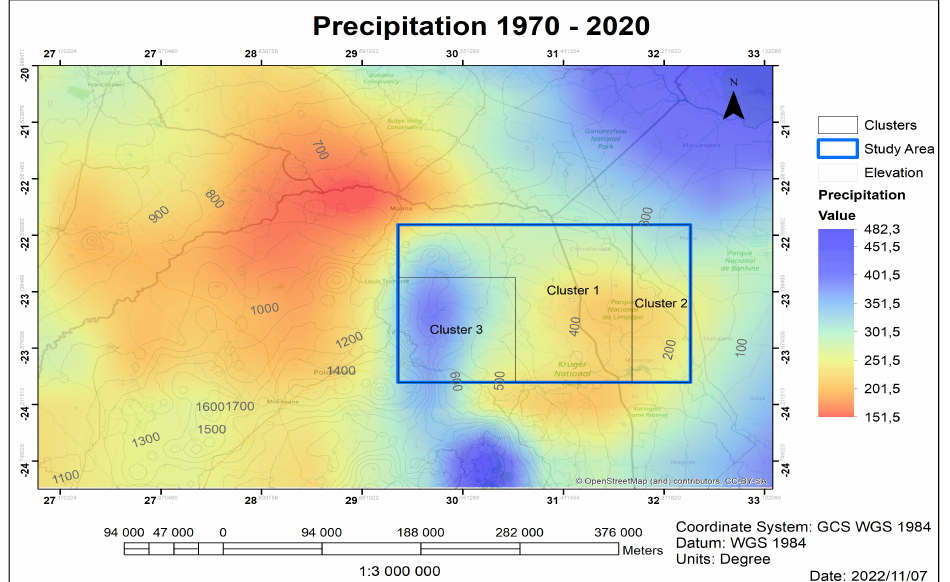
Figure A1. Map for the annual average precipitation in the Lowveld region of Limpopo with three clusters. Source: Authors’ creation.